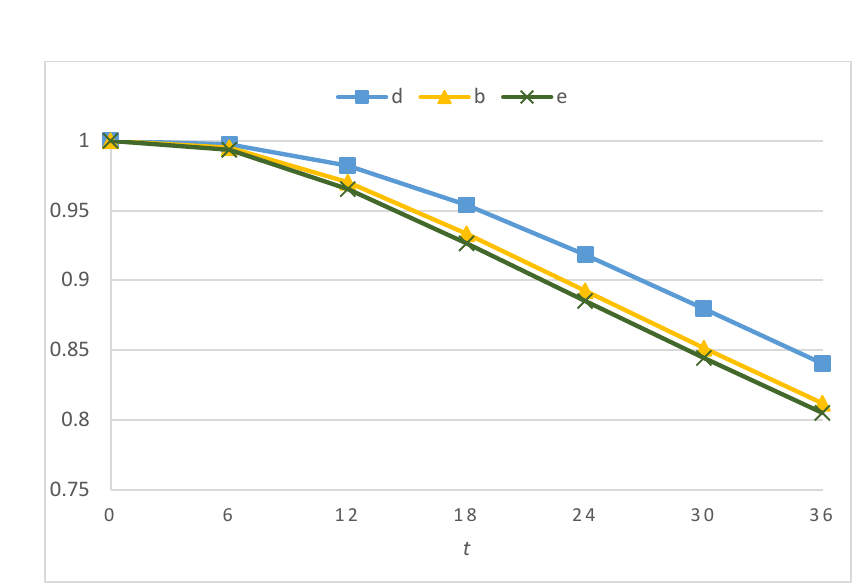
Figure 4. Impacts of parameters 𝜆